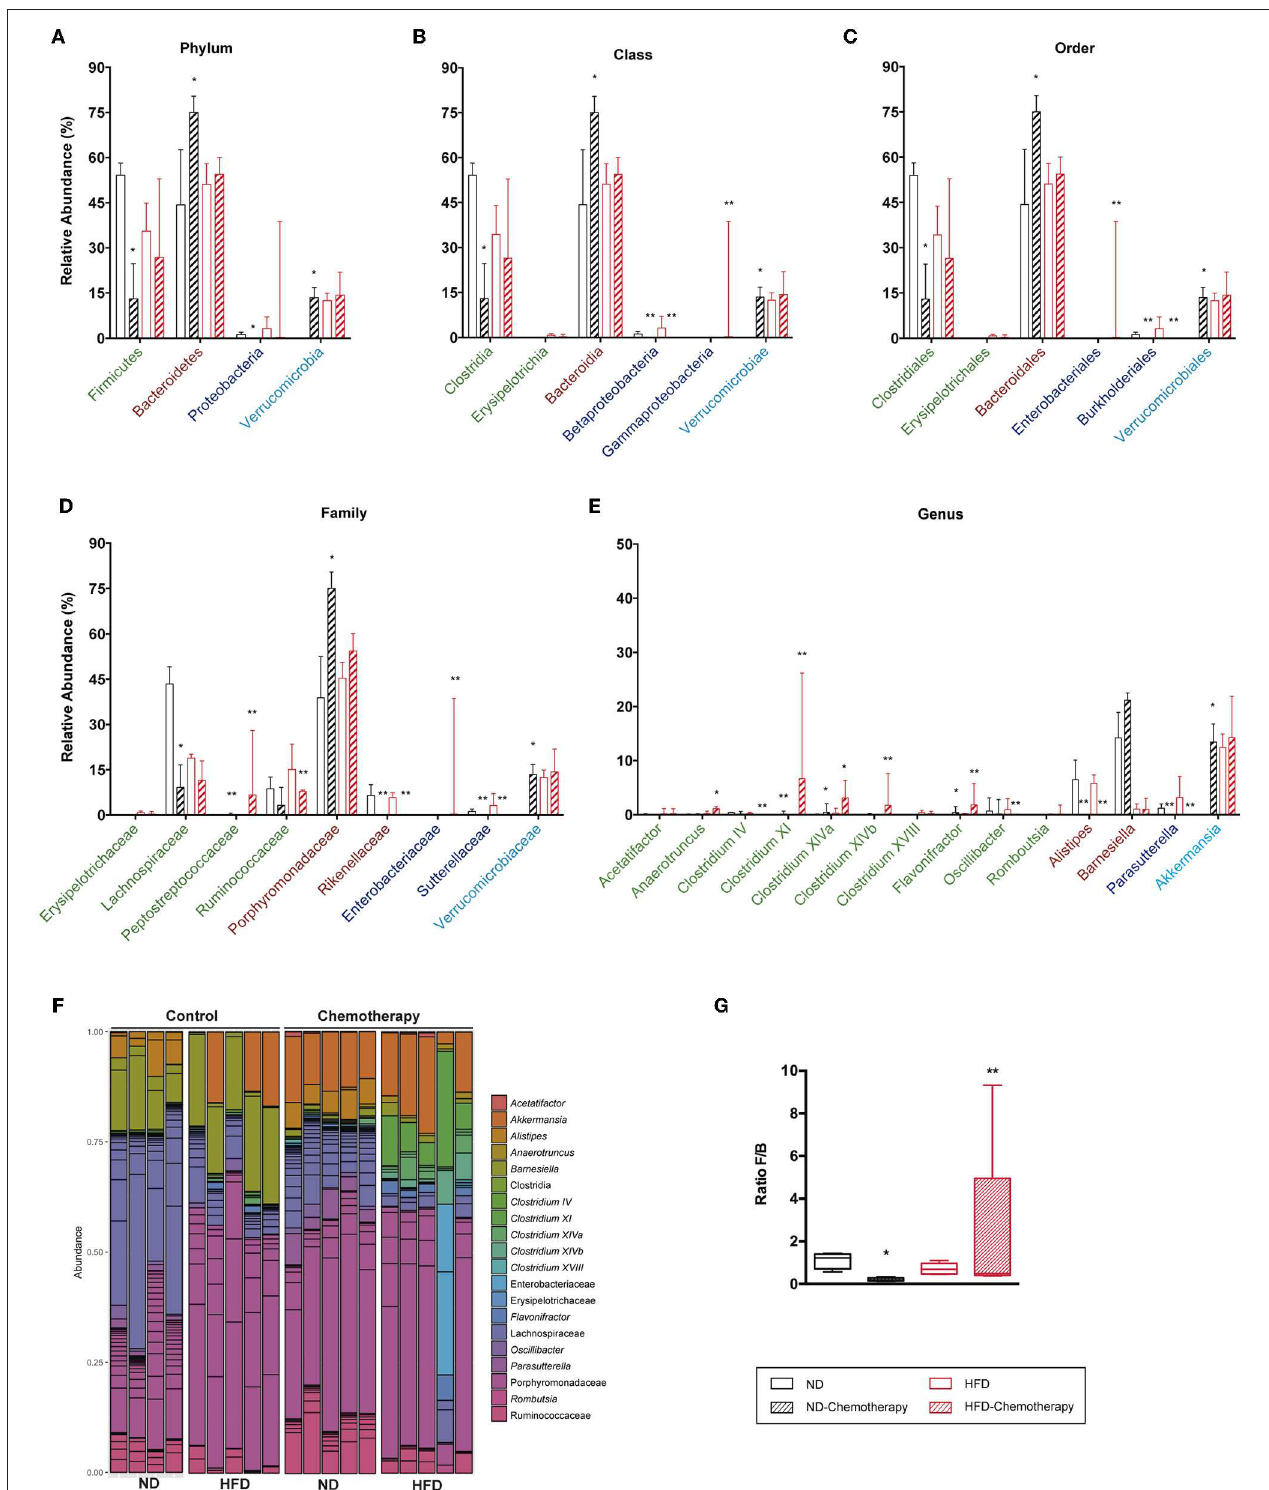
FIGURE 11 | Taxonomic composition of the intestinal microbiota based on 16S rRNA sequencing between different diets and under chemotherapy. Analysis of the relative abundance of the most abundant phylum (A) , class (B) , order (C) , family (D) , and genus (E) . (F) Bar plot representation of the OTUs of each sample according the taxonomic classification. (G) Analysis of the F/B ratio. * p < 0.05, ** p < 0.01; Mann–Whitney test.